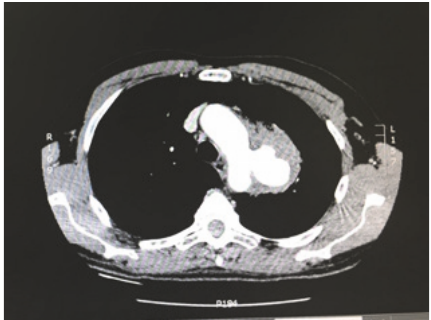
Figure 1: CT with intravenous contrast showed a 5,5 cm saccular aneurysm of descending thoracic aorta.